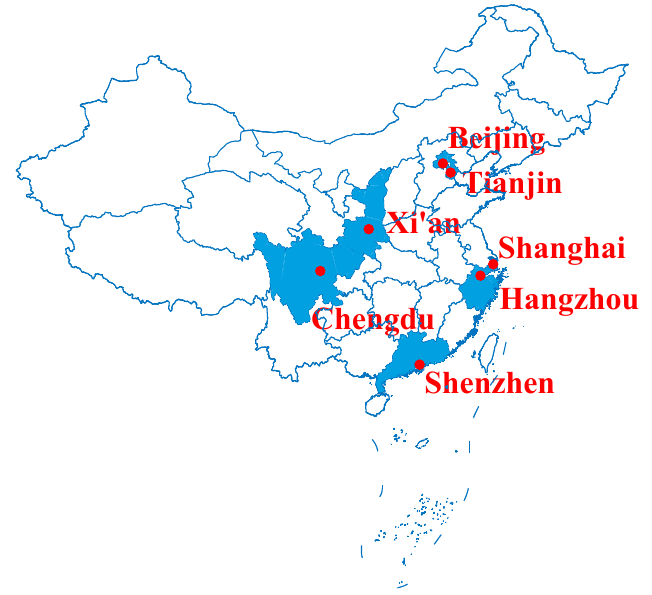
Figure 1. Cities spatial distribution. Table 1. Vehicle attributes used in this research.